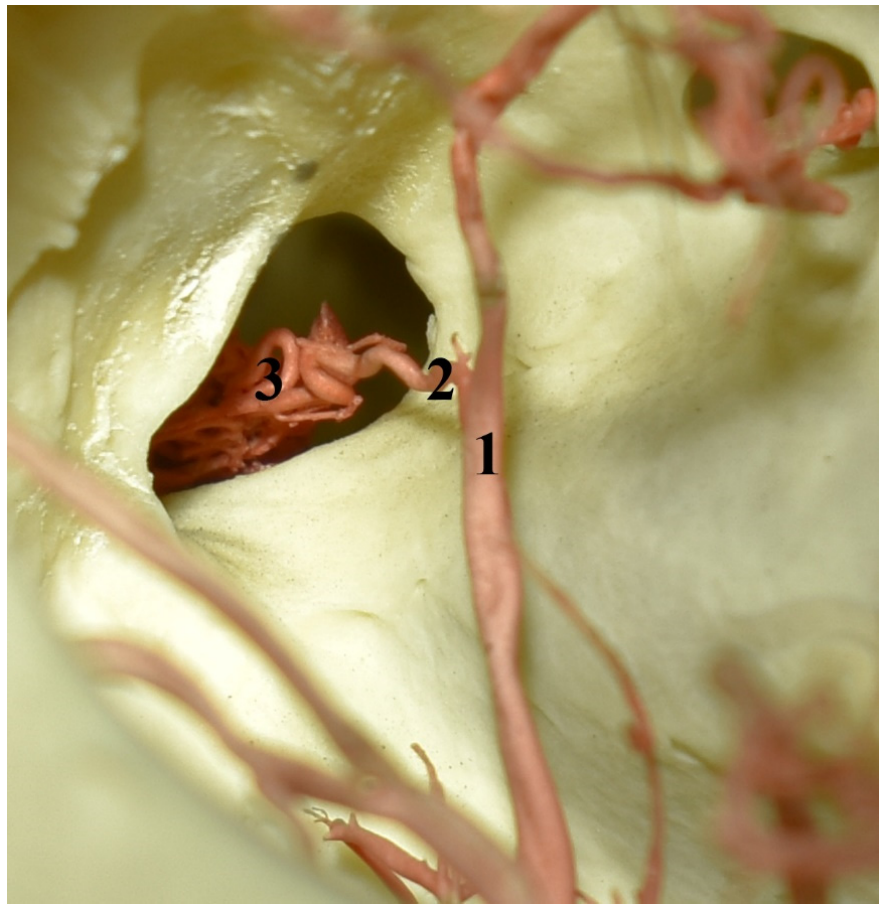
Figure 6. The eye socket of the collared peccary ( Pecari tajacu ). A caudolateral view and corrosion cast. 1—external ophthalmic artery; 2—rostral branch to the rostral epidural rete mirabile; 3—rostral epidural rete mirabile.